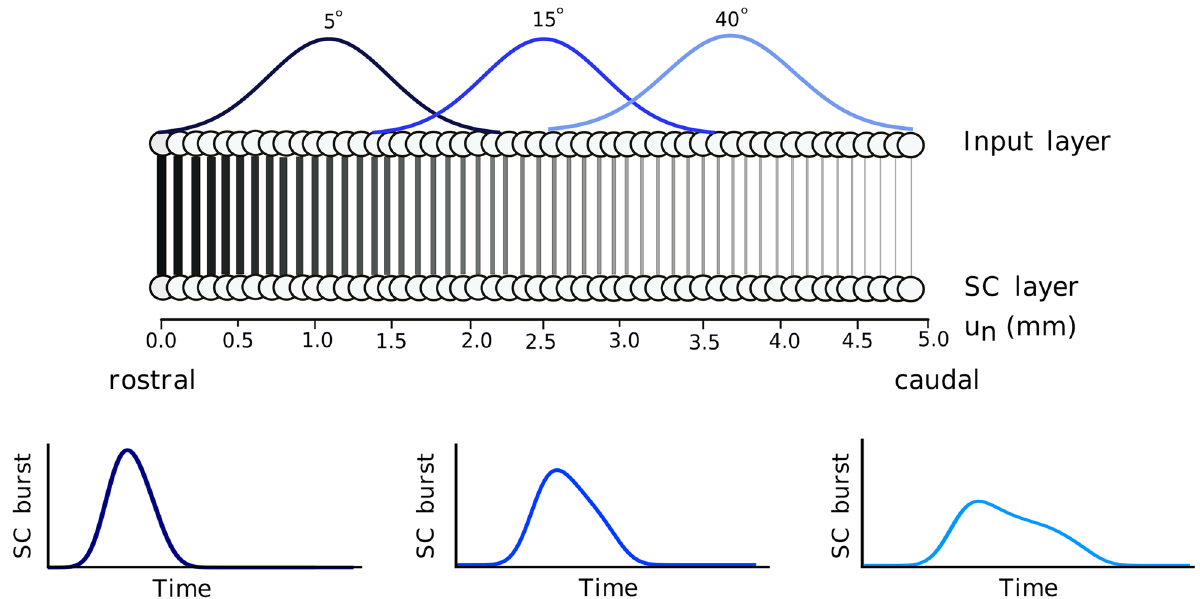
Figure 2. Schematic overview of the two-layer feedforward neural network. The spiking neural network model generates different saccade-related bursts (bottom) that are evoked by a spatially translation-invariant input population (top), here positioned at T = 5, 15 and 40 deg eccentricity. Thickness of the lines for the downward FS projections symbolizes the synaptic connection strengths, w n , between the input and SC layers (high for the rostral zone, low for the caudal zone; Eq.